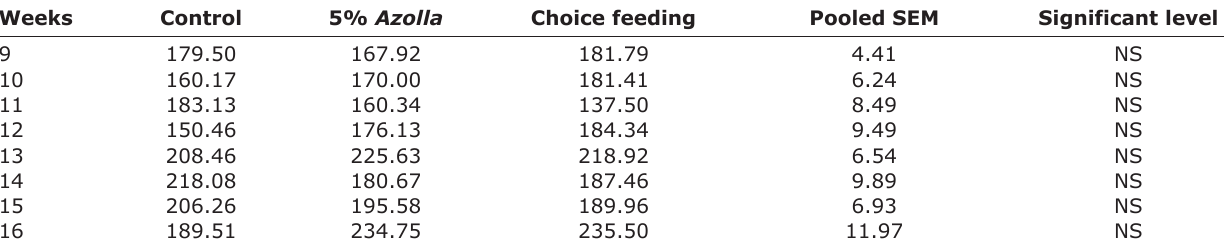
Table-2: Effect of Azolla feeding on the average weekly body weight gain (g) of grower turkeys during 8-16 weeks of age. Weeks